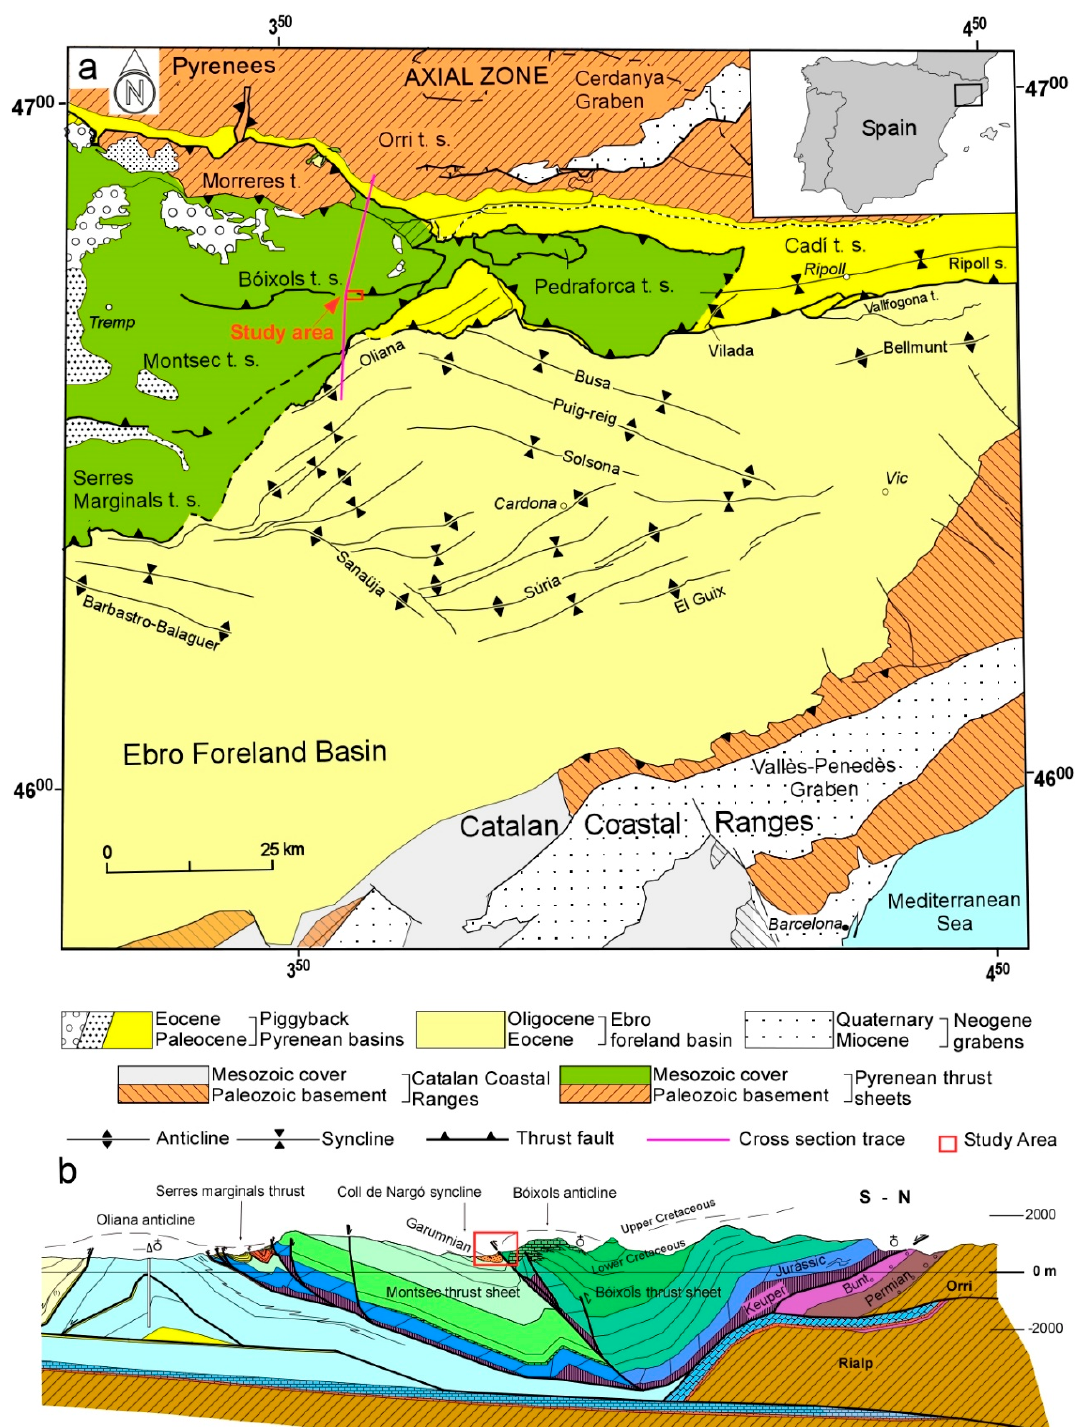
Figure 1. Geological map ( a ) and cross-section ( b ) of the South-Central Pyrenean Unit, showing the main structural units. The study area is located in the frontal part of the Bóixols thrust sheet. Modified from [59].